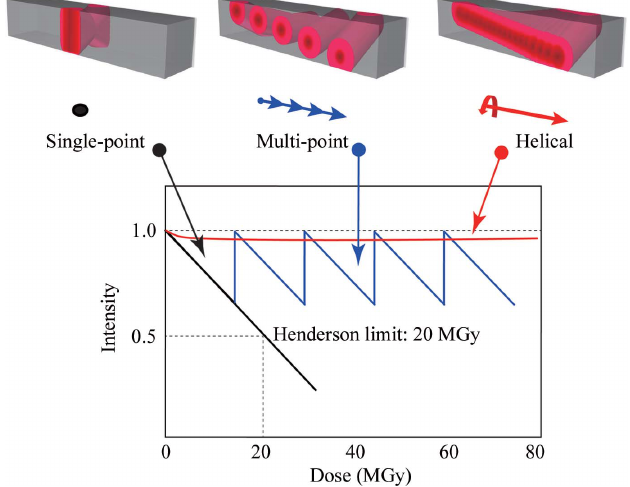
Figure 4 Schematic drawing of data-collection strategies and each change of diffraction intensity from a single crystal using a microbeam. The total image number in single-point data collection is limited by radiation damage. Multi-point data collection can increase the total image number by avoiding serious radiation damage by using a fresh crystal volume with translation of the irradiation point. Helical data collection enables an equal distribution of radiation damage over the entire crystal volume. Thus, the helical method gives completely smoothed scales and B factors for frames, which finally improves the data